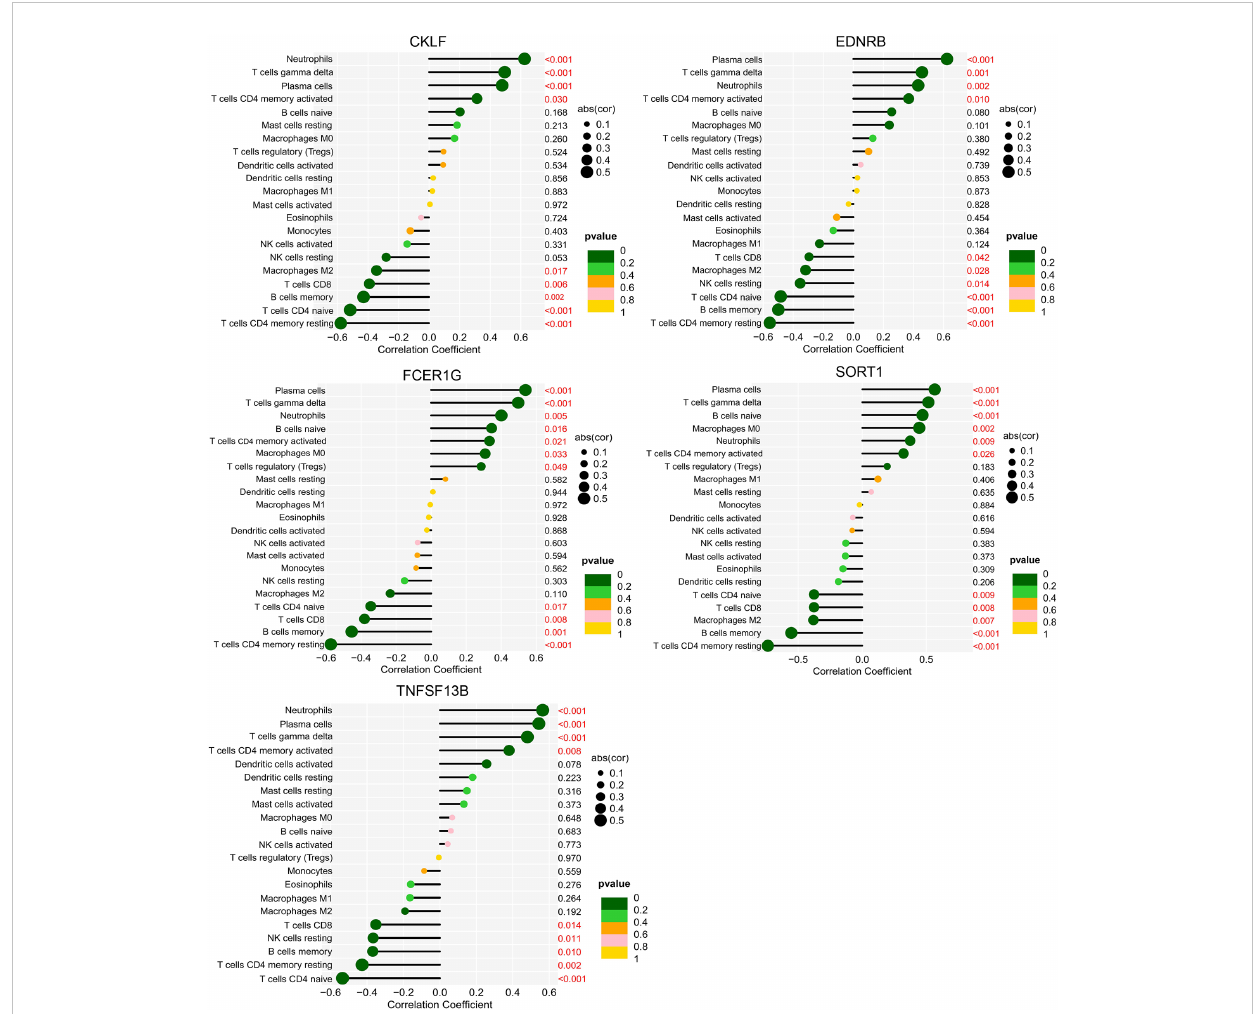
FIGURE 13 Correlation between biomarkers and immune cells in SCI. The ordinate on the left represents the proportion of immune cells, the ordinate on the right represents the P value of the correlation test, and the abscissa represents the correlation coef fi cient. The size of the circle represents the correlation coef fi cient, and the color of the circle represents the P value of the correlation test; a P value<0.05 was considered statistically signi fi cant. SCI, spinal cord